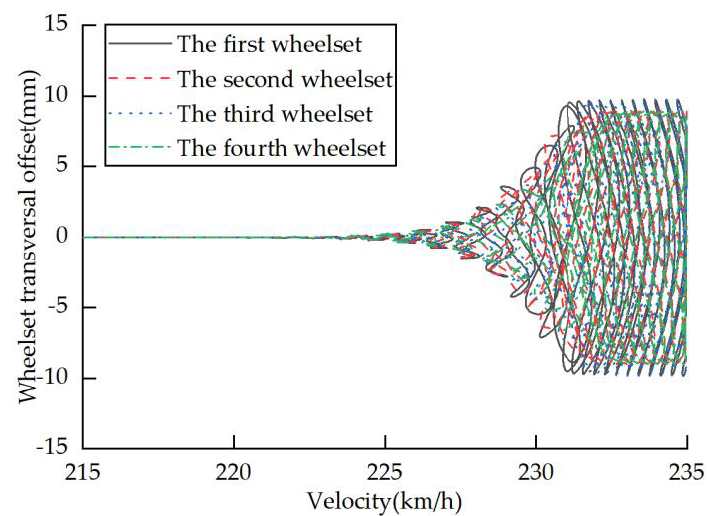
Figure 8. The nonlinear critical speed of the single trailer.